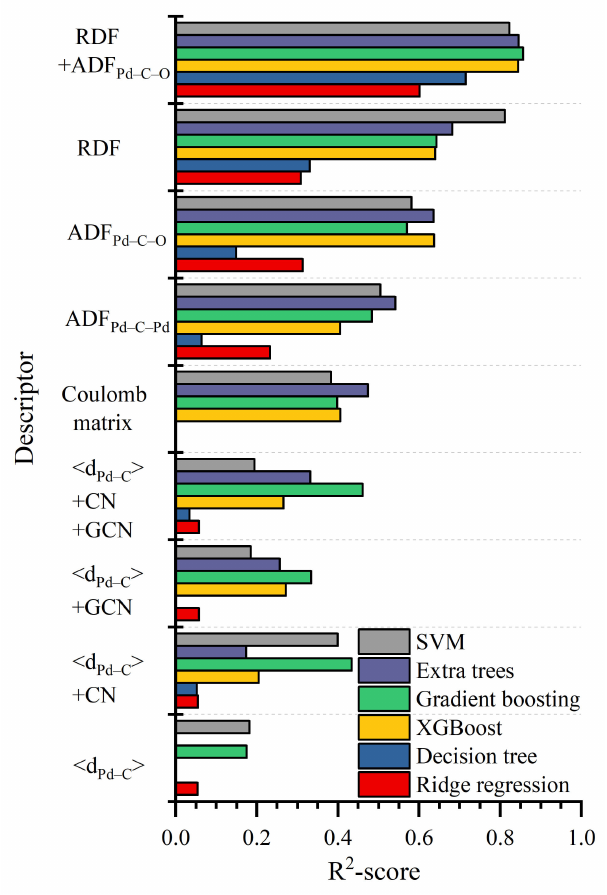
Figure 3. Comparison of the quality of prediction of binding energy when using different descrip- tors/ML